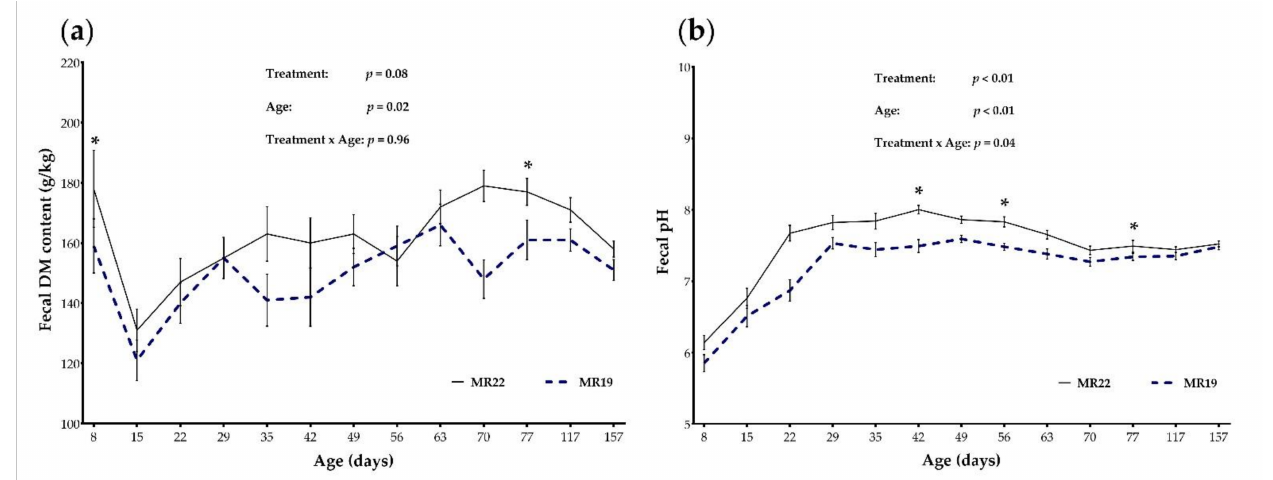
Figure 2. Means and standard error bars of fecal dry matter (DM) content ( a ) and fecal pH ( b ) measured in calves fed with milk replacer content 22% CP (MR22; n = 35) or 19% CP (MR19; n = 33), according to time periods. * Denotes difference between MR19 and MR22 with p < 0.05.